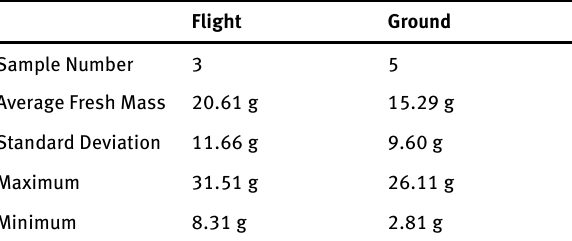
Table 3. Average fresh mass of flight and ground lettuce plants from VEG-01A. Plants were harvested, frozen at -80°C, returned to Earth, and weighed while still frozen. Standard deviations and maximum and minimum values are presented to highlight